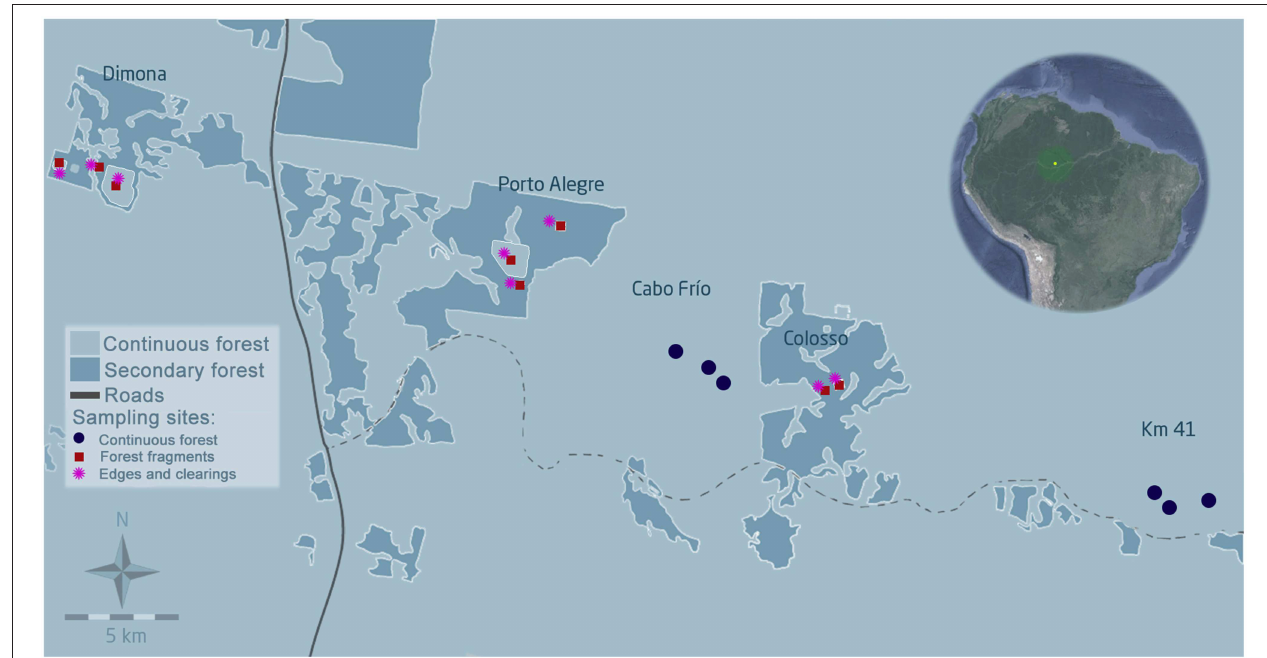
FIGURE 1 | Map of the study area in the central Amazon. Image © DigitalGlobe/CNES/Airbus. Experimental areas within the BDFFP landscape are delineated by a white border (Km 41 and Cabo Frio for continuous forest and Dimona, Colosso, and Porto Alegre for forest fragments); continuous forest is represented in light blue and secondary vegetation matrix in dark blue. The image in the upper right corner shows the location of the study